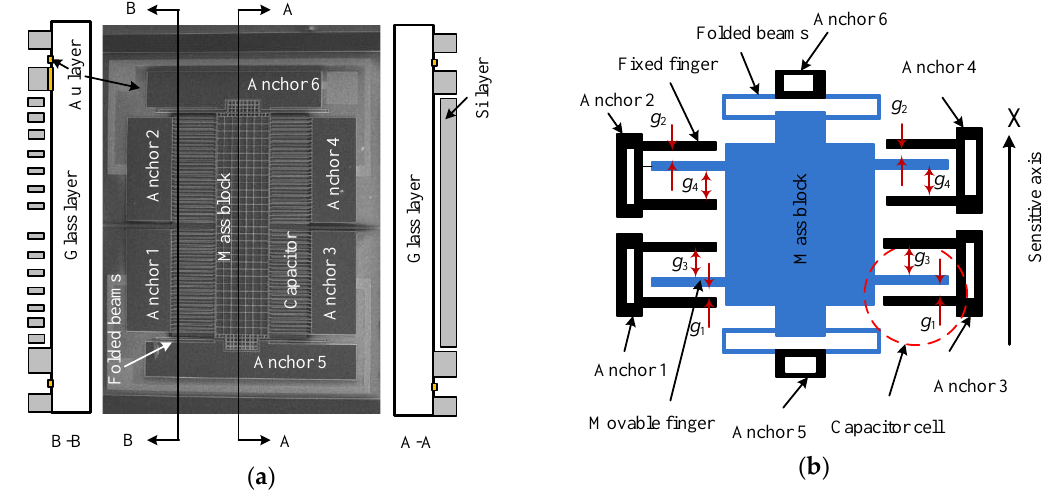
Figure 1. Sensor chip of the micro-accelerometer: ( a ) bi-layer structure of the micro-accelerometer; and ( b ) the simplified model of the sensor structure.